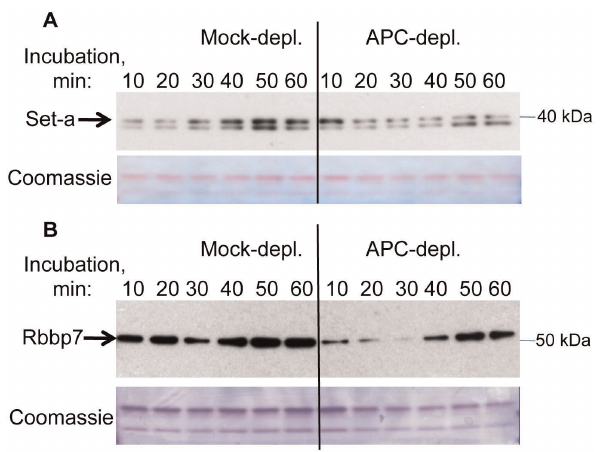
Figure 6. Effect of APC depletion on association of Set-a and Rbbp7 with chromatin. Immunoblotting of chromatin samples prepared as for proteomic screen, with antibodies against Set-a (A) and Rbbp7 (B), as well as the Coomassie staining of the bottom portions of the gel used as a loading control. Each lane contains the equivalent of 200 ng